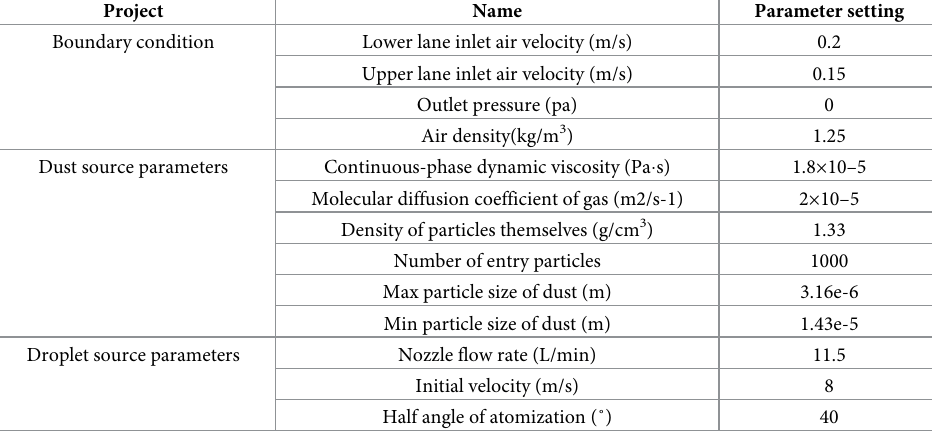
Table 1. Boundary conditions and parameter